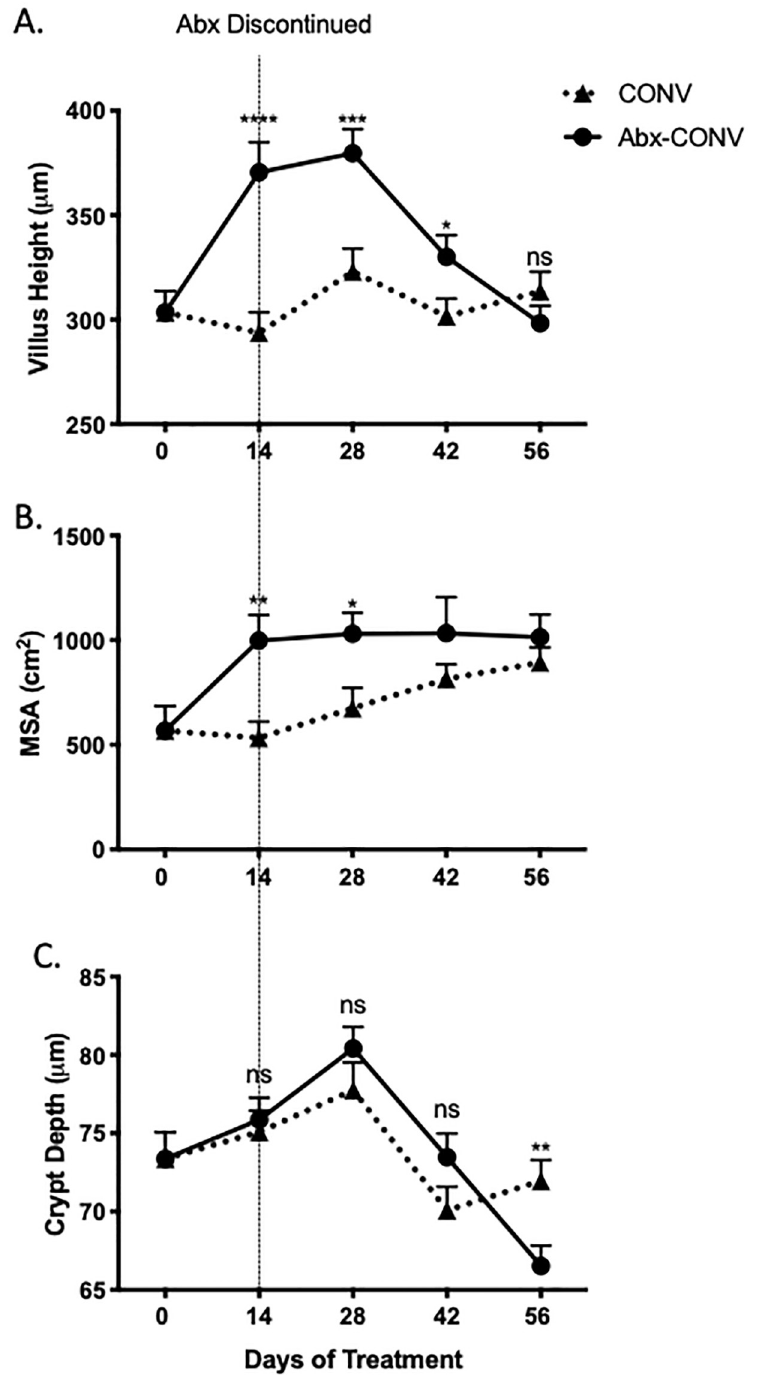
Fig 7. Cessation of antibiotic treatment and reversal of mucosal changes. (A) Antibiotic treated mice demonstrated significant increases in villus height after 14 days of antibiotic therapy, though returned to baseline by day 56. (B) Calculated mucosal surface area (MSA) was greater in antibiotic treated mice at day 14 of treatment and returned to baseline after cessation of antibiotics by day 42. (C) There were no significant (ns) difference noted in crypt depth between the two groups. Values presented as Mean ± SEM; � p < 0.05, �� p < 0.01, ��� p < 0.001, ���� p < 0.0001; n = 12 mice.